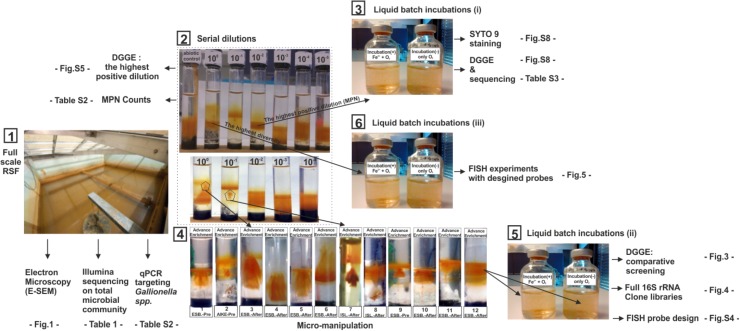
Overview of experimental sequence and methods used in this study. (1) Experiments used cell extracted from filter materials recovered from full-scale RSFs (2) A representative set of Fe2+/O2 opposing gradient serial dilution tubes for IOB MPN enumeration and enrichments. First tube on the left is a control tube without cell inoculation; tubes labeled from 100 to 10-5 are inoculated with 10 μl of 10-fold serially diluted cell suspensions. (3) Verification of Fe2+ dependent growth in liquid cultures by comparing results of DGGE and Syto-9 staining of incubations with and without Fe2+ amendment (4). Microsampling at distinct locations of the IOB enrichment band in the original Fe2+/O2 gradient tube (5) Verification of Fe2+ dependent growth in liquid cultures by comparison of DGGE, clone libraries and (6) FISH images of incubations with and without Fe2+ amendment. FISH probes were designed from the clone library constructed at (5).